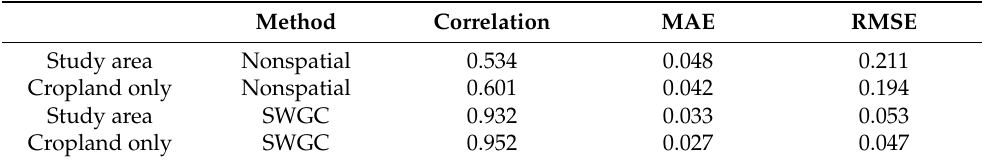
Table 1. Average accuracy of nonspatial growth curve and SWGC methods for NDVI prediction for the Landsat-8 test